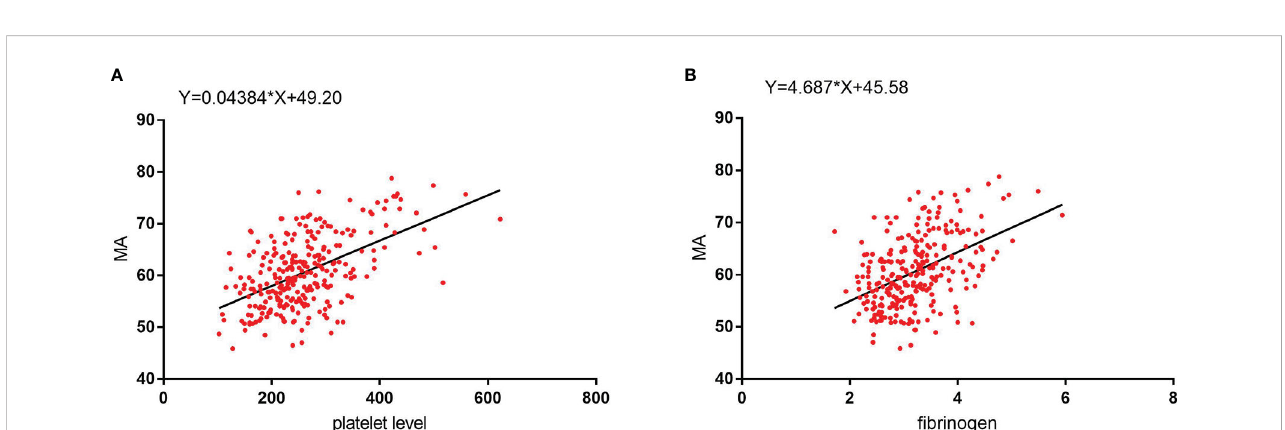
FIGURE 5 (A) MA values show a signi fi cant positive linear correlation with platelet level. (B) MA values show a signi fi cant positive linear correlation with fi brinogen